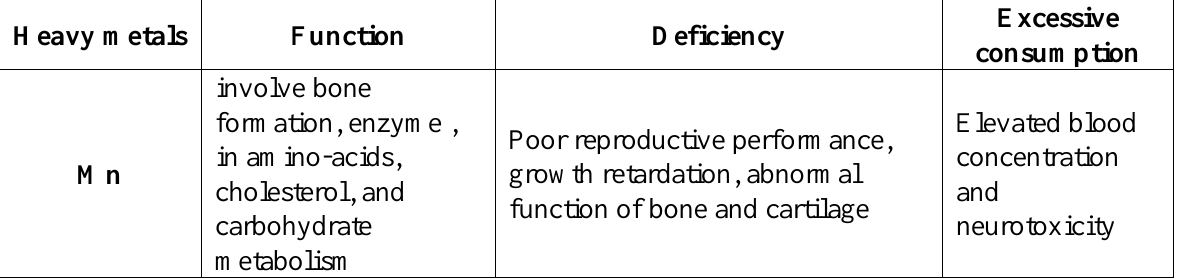
Table 2. The function, deficiency and excessive consumption of the studied heavy